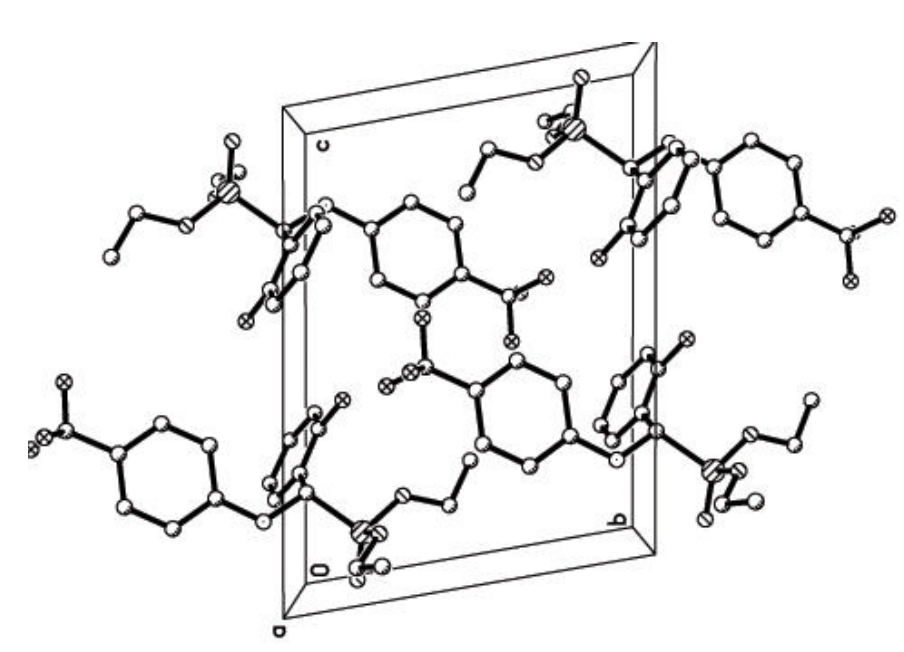
Figure 3. The packing diagram of the unit cell